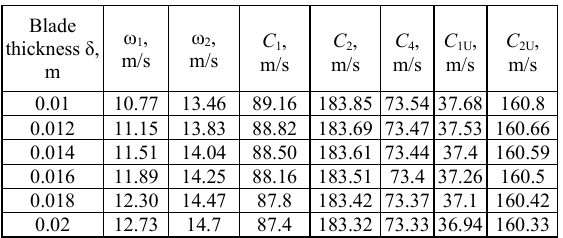
S PEED C OMPONENTS OF THE S TAGE FOR 42 M 3 / MIN G AS F LOWRATE Blade thickness δ ,